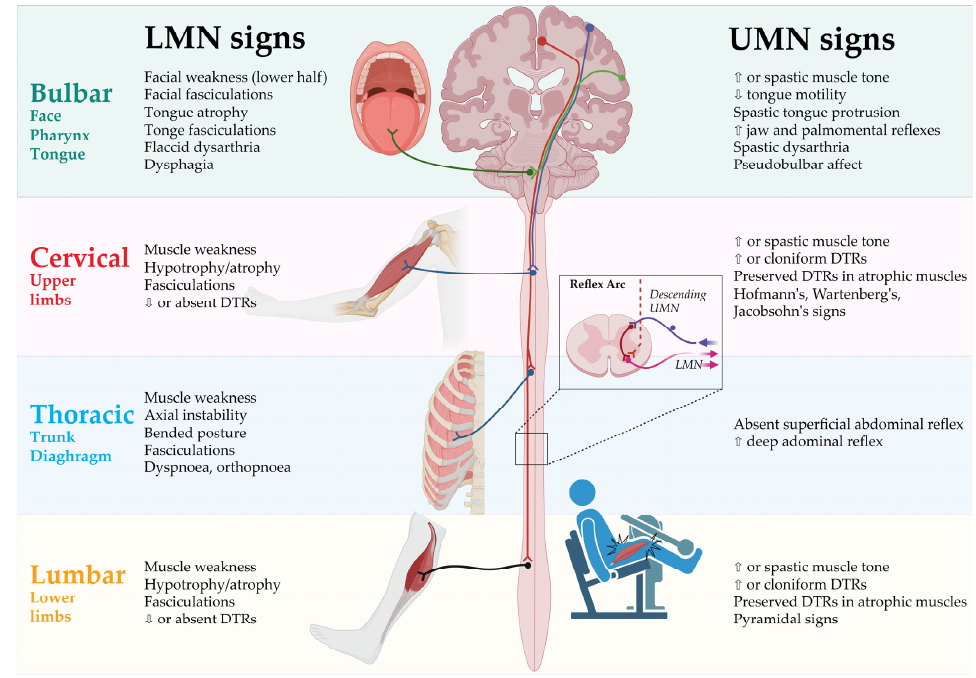
Figure 1. Clinical signs of UMN and LMN involvement according to body regions. DTR: Deep tendon reflex; LMN: Lower motor neurons; UMN: Upper motor neurons. Created by Castro-Gomez with “BioRender.com”; accessed on 04 February 2023.